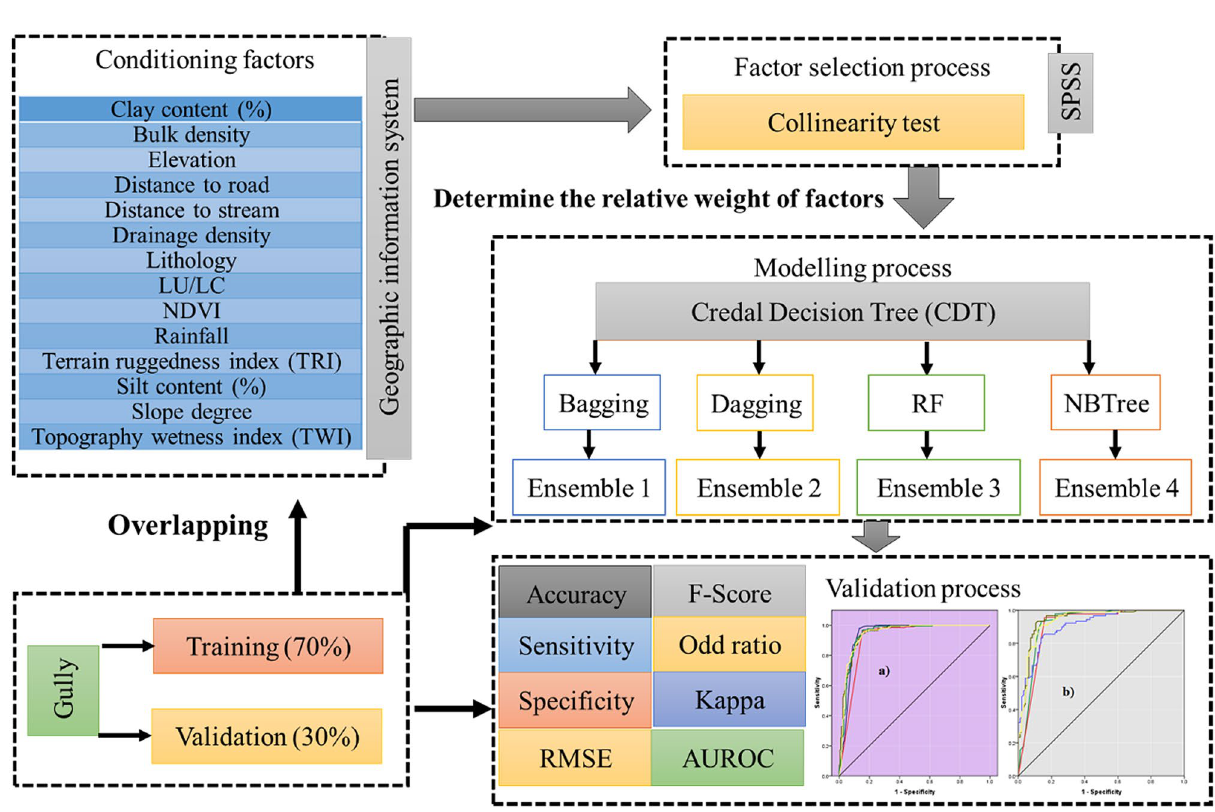
Figure 8. Flowchart of the methodology adopted in the current